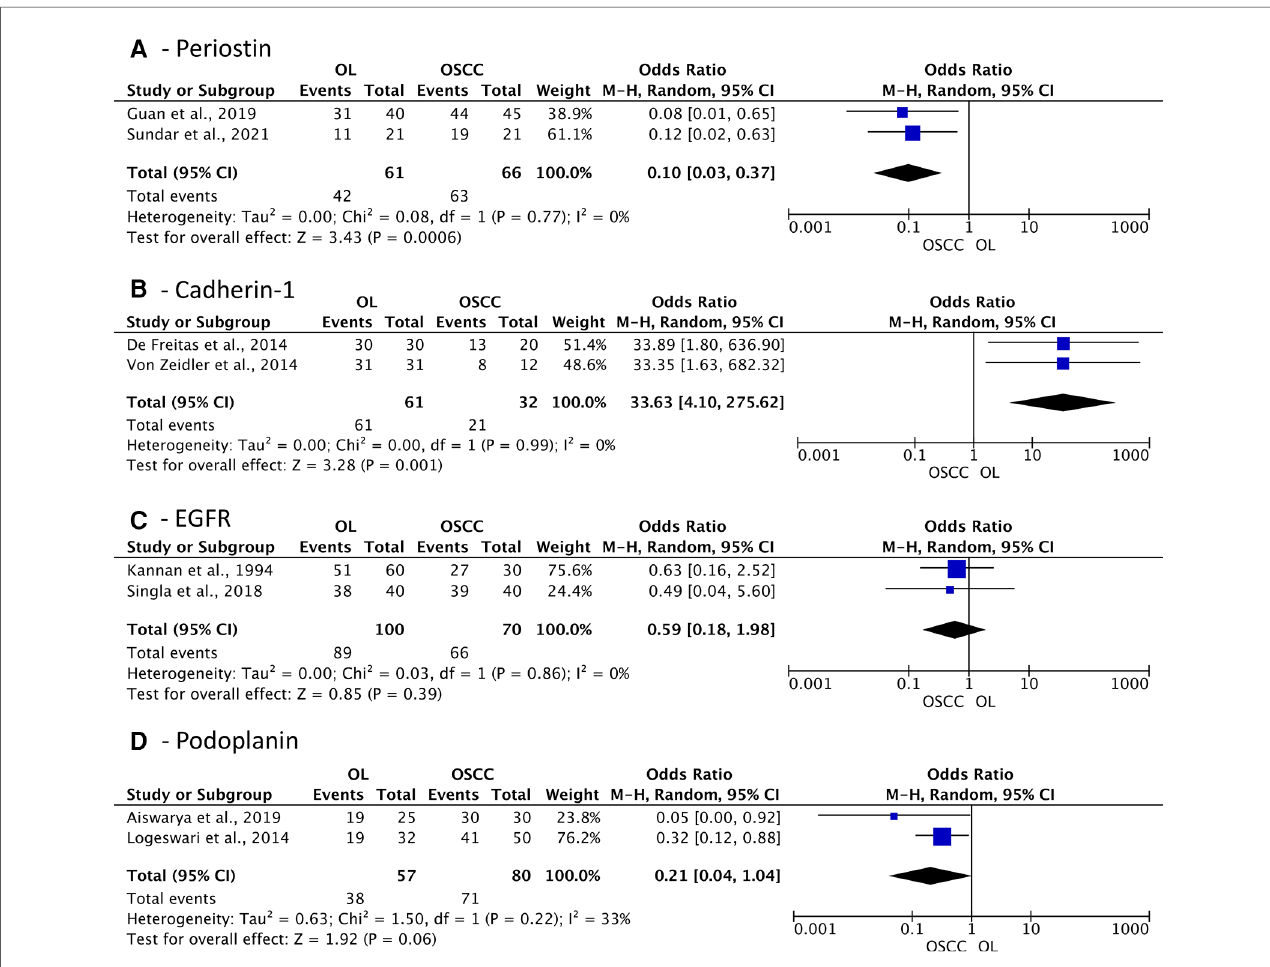
FIGURE 6 Association of expression of cell migration and cell adhesion proteins in oral leukoplakia (OL) compared to oral squamous cell carcinoma (OSCC). ( A ) Periostin; ( B ) Cadherin-1; ( C ) EGFR; ( D )